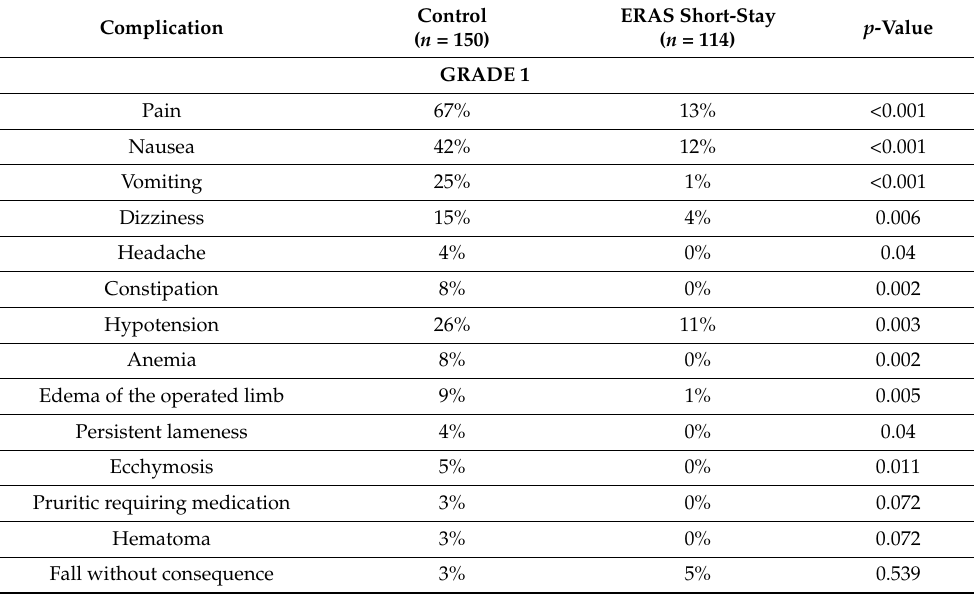
Table 1. Complications rates per group (Control vs. ERAS short-stay) according to the Clavien-Dindo classification